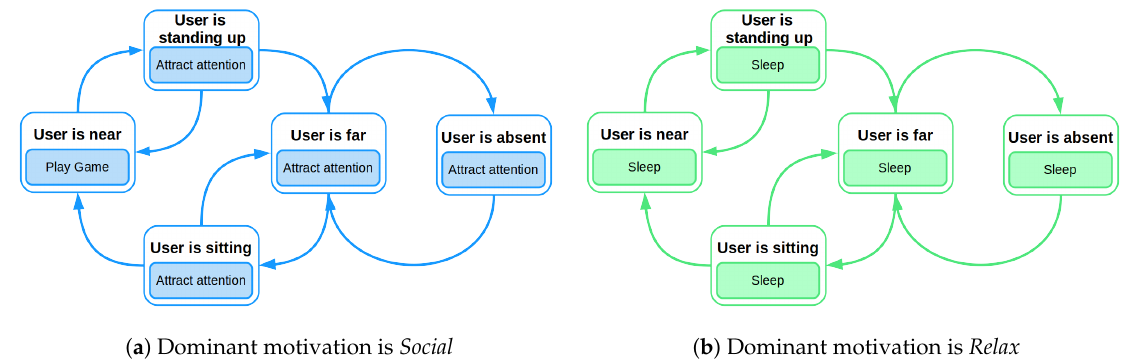
Figure 8. Policies learned by the robot with the different dominant motivations.